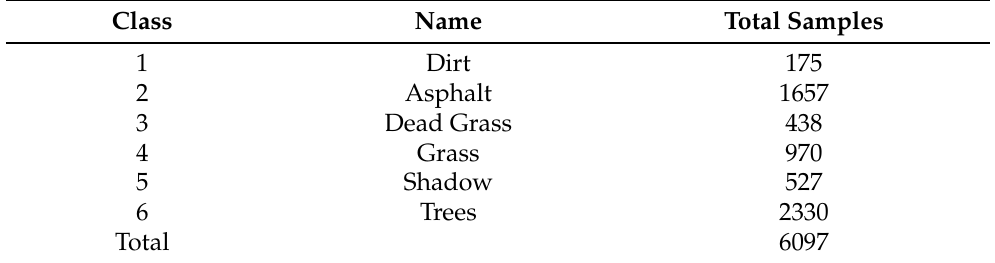
Table 3. Groundtruth classes for Gulfport of Mississippi scene and their respective samples